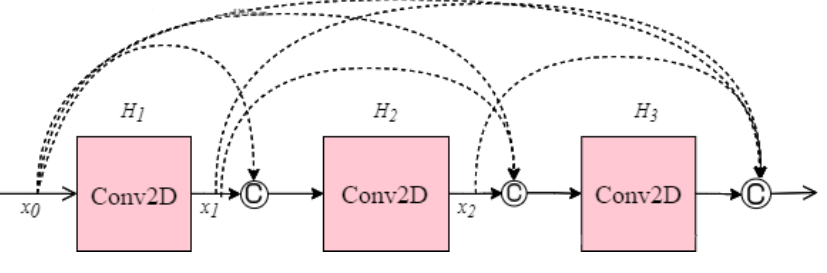
Figure 8. Single dense block.